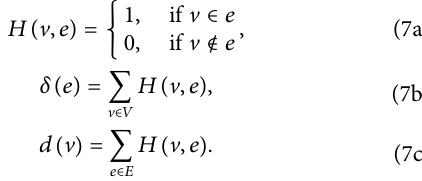
FIGURE 2 | Sketch of an HKNN.